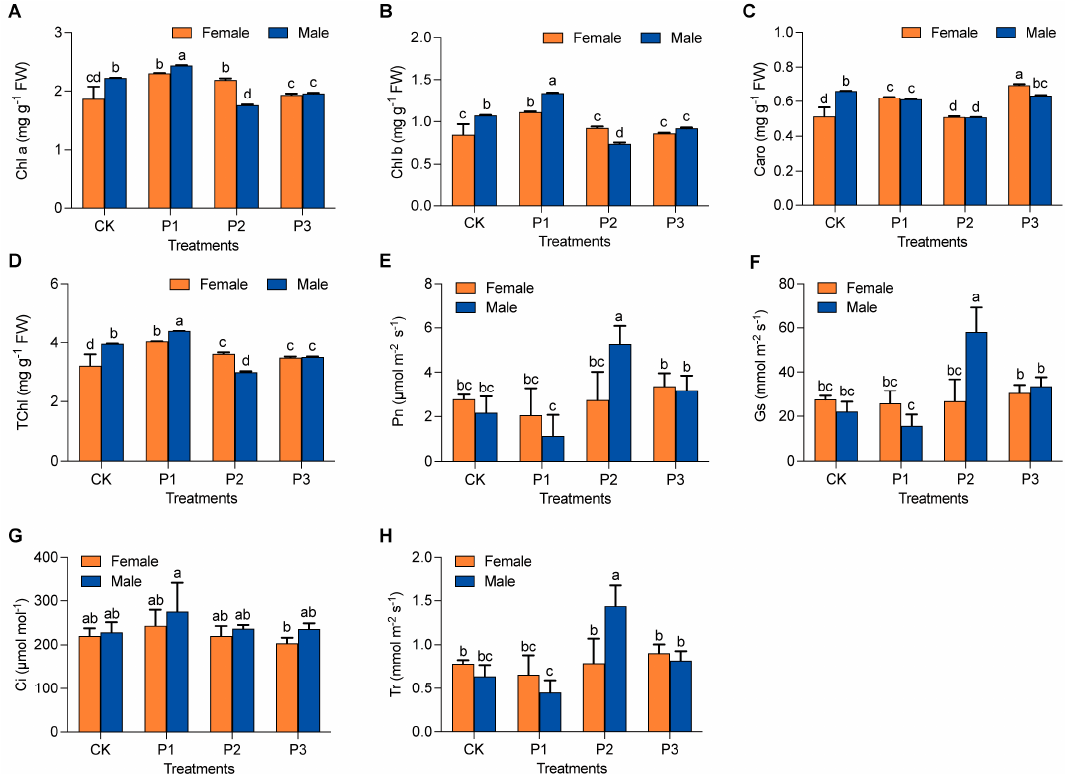
Figure 2. Chlorophyll pigments and photosynthetic parameters in L. cubeba female and male leaves under control and Pb treatments: ( A ) Chl a, chlorophyll a; ( B ) Chl b, chlorophyll b; ( C ) Caro, carotenoids; ( D ) TChl, total chlorophyll; ( E ) Pn, net photosynthetic rate; ( F ) Gs, stomatal conductance; ( G ) Ci, intercellular CO 2 concentration; and ( H ) Tr, transpiration rate. CK, P1, P2, and P3 represent 0, 1, 2, and 3 mmol Pb/kg dry soil, respectively. Values are the mean of three replicates ± SE. Values followed by different lowercase letters significantly differed, according to Duncan’s test ( p < 0.05).